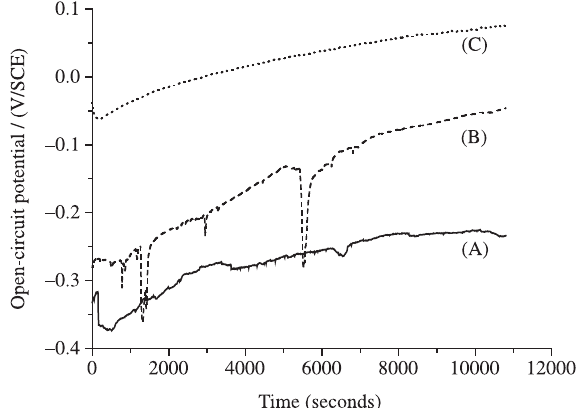
Figure 2. Variation of open-circuit potential for the three Ti implants in artificial saliva.